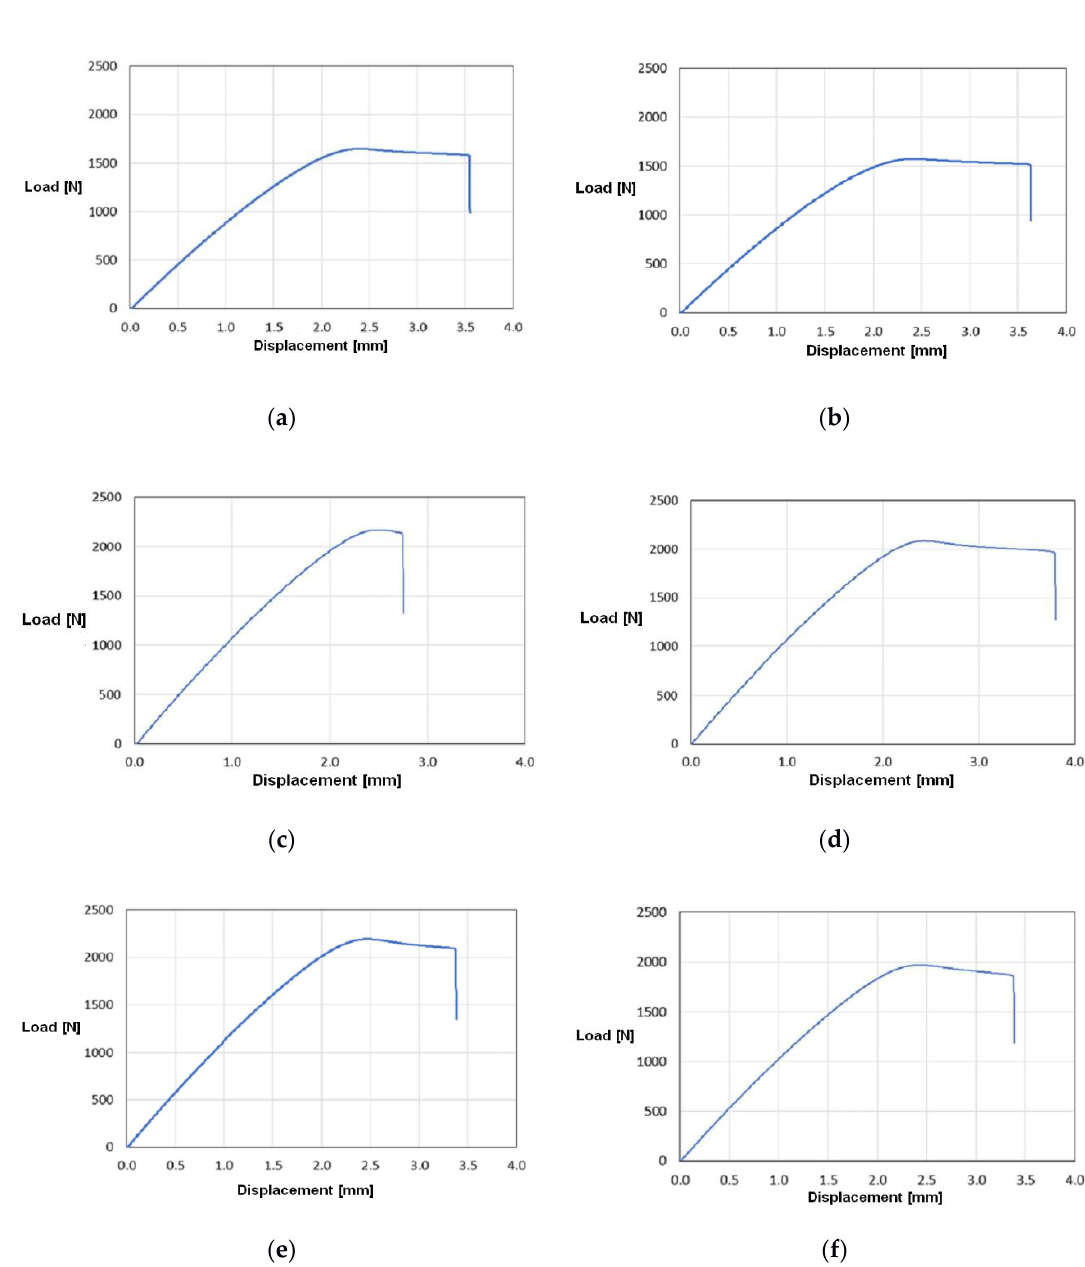
Figure 5. Tensile force of the selected exoskeleton sample under various material conditions: PLA+: Weak part ( a ), optimal part ( c ), strong but heavy part ( e ), PLA: Weak part ( b ), optimal part ( d ), and strong but heavy part ( f ).